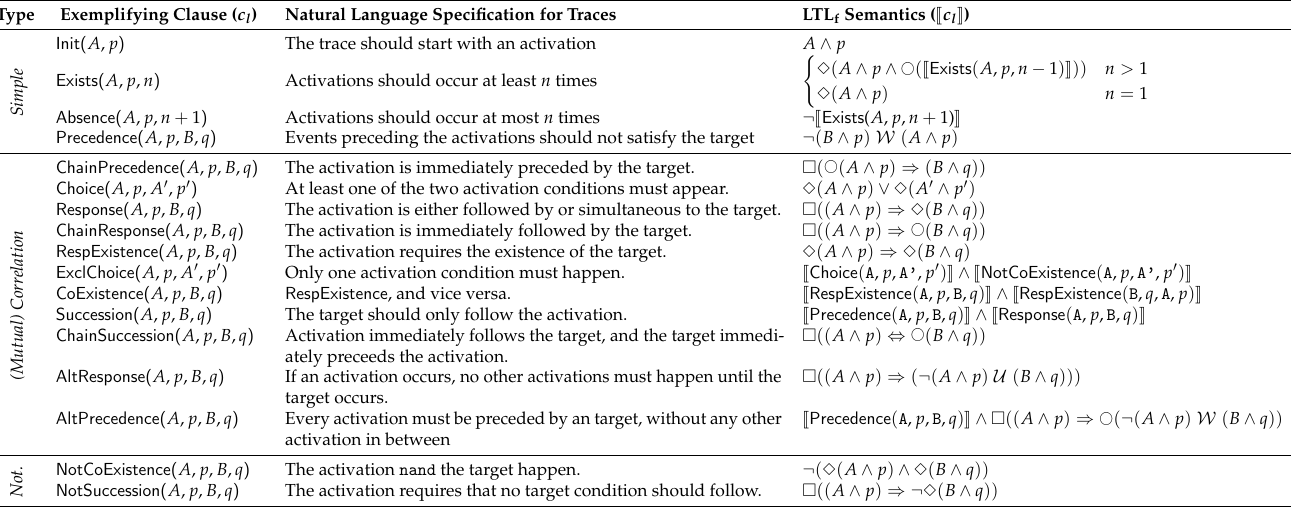
Table 1. Declare templates illustrated as exemplifying clauses. A ∧ p ( B ∧ q ) represents the activation ( target ) condition, A ( B ) denotes the activity label, and p ( q ) is the data payload